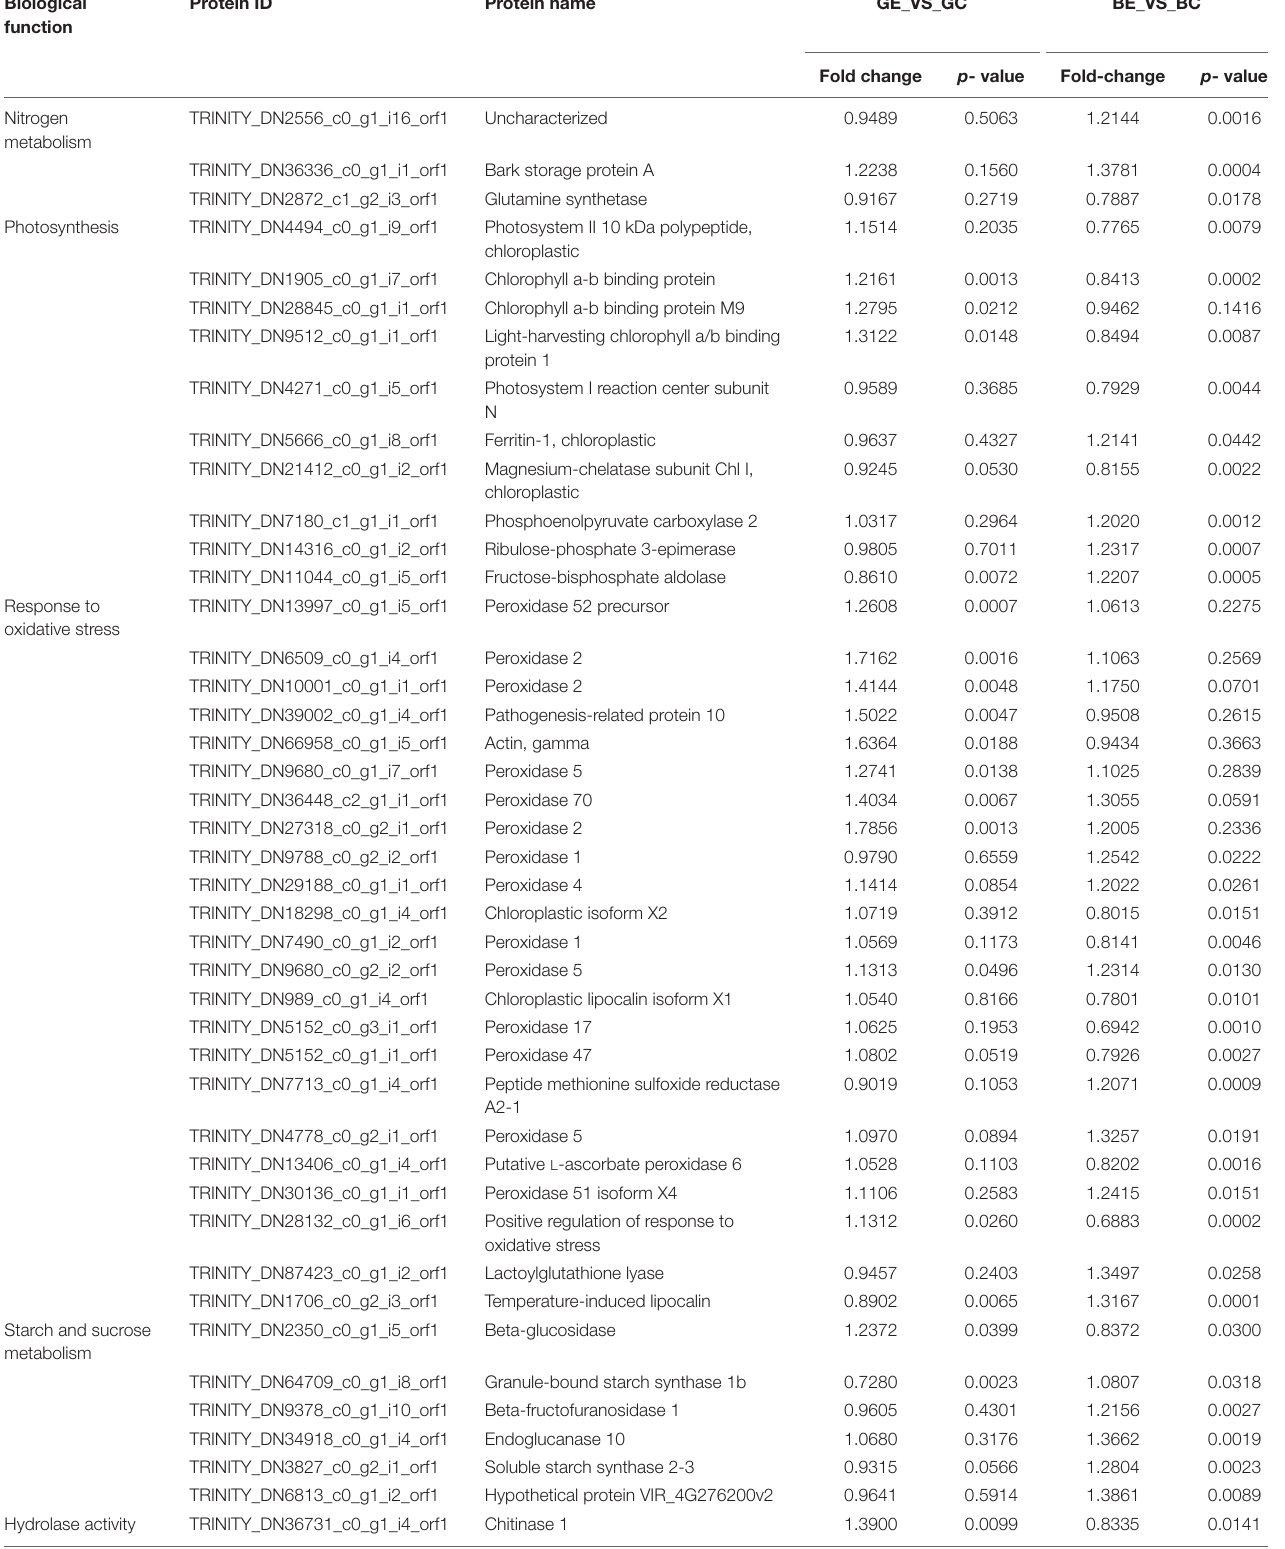
TABLE 2 | List of differentially expressed proteins in two sugarcane varieties inoculated with the diazotroph E. roggenkampii ED5 as compared to control. Biological